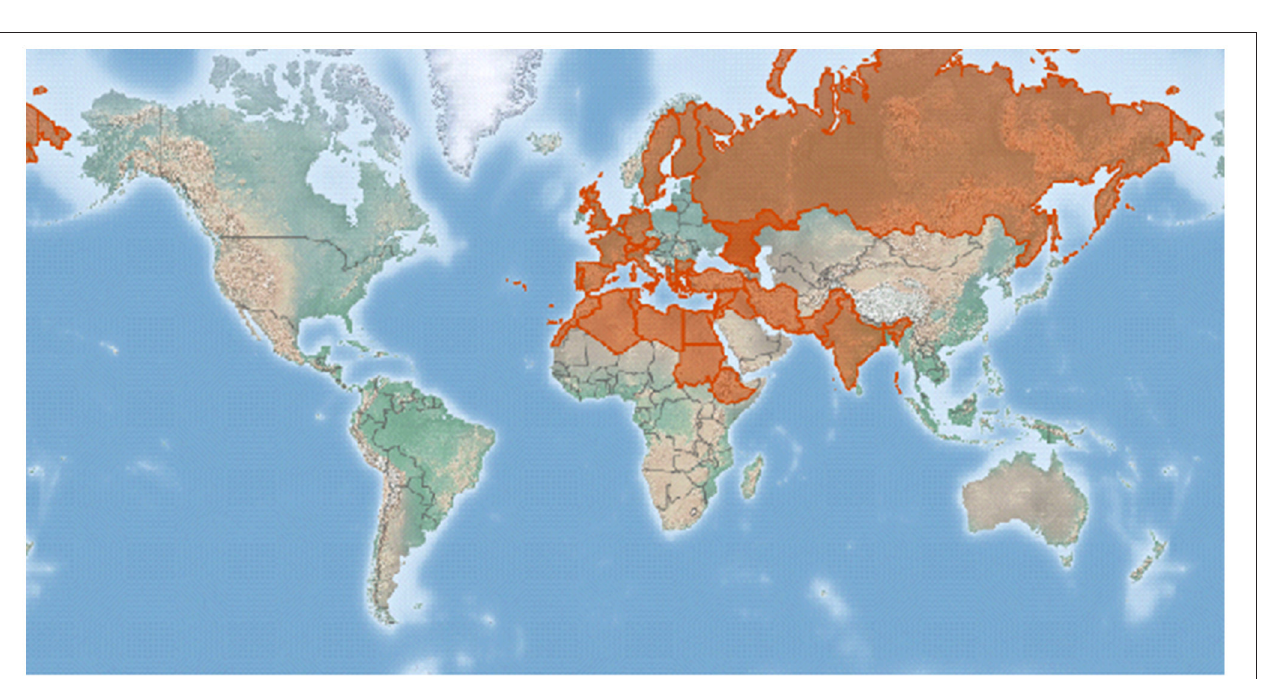
FIGURE 2 | A map showing the crenate broomrape distribution represented by a red color in the world after CABI (2021).